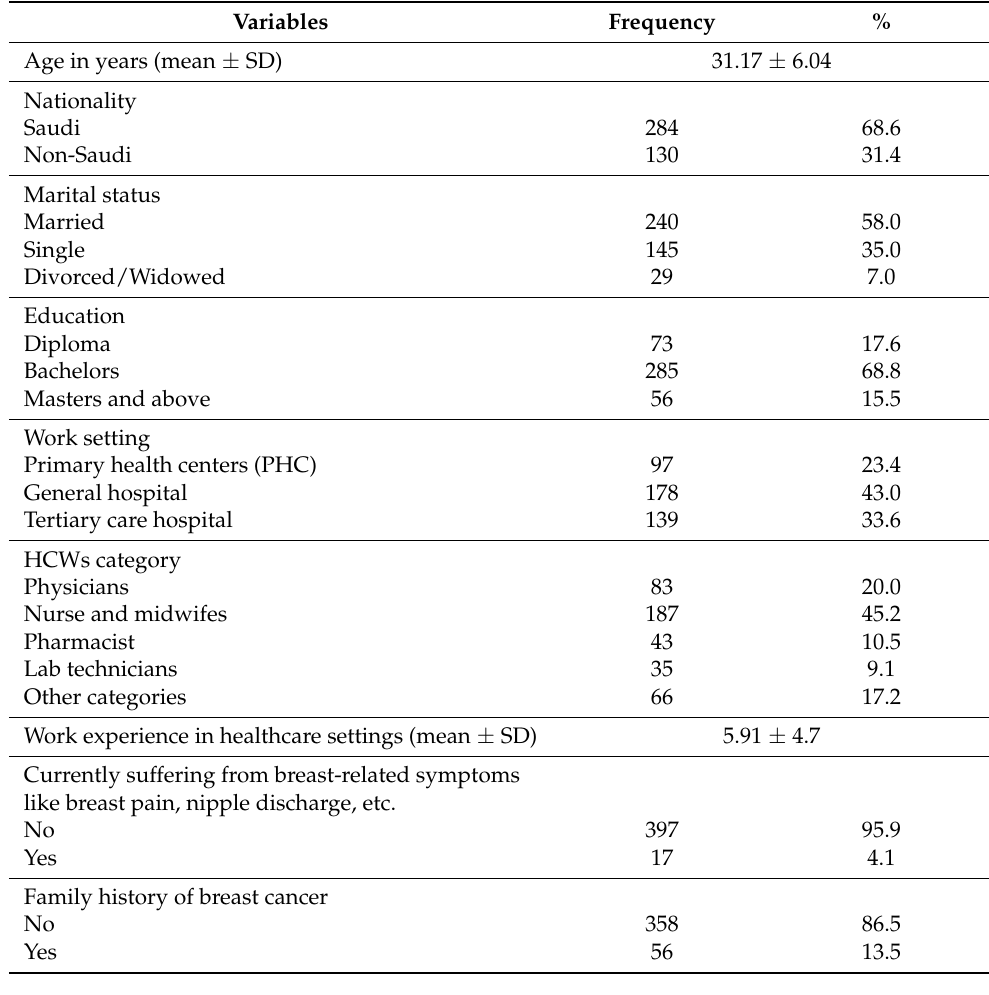
Table 1. Background characteristics of the female healthcare workers (HCWs) ( n =